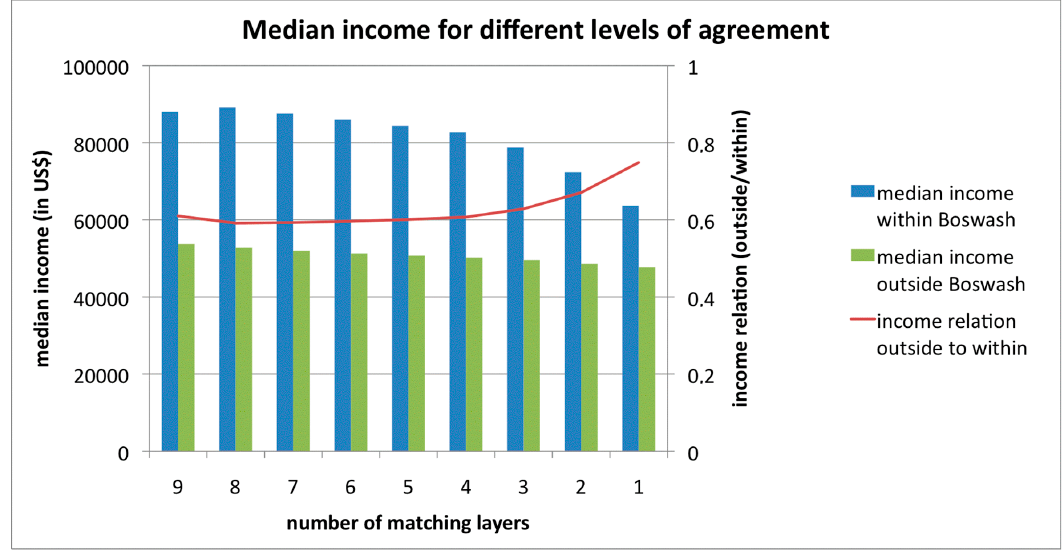
Figure 5. Median income for different Boswash extents.